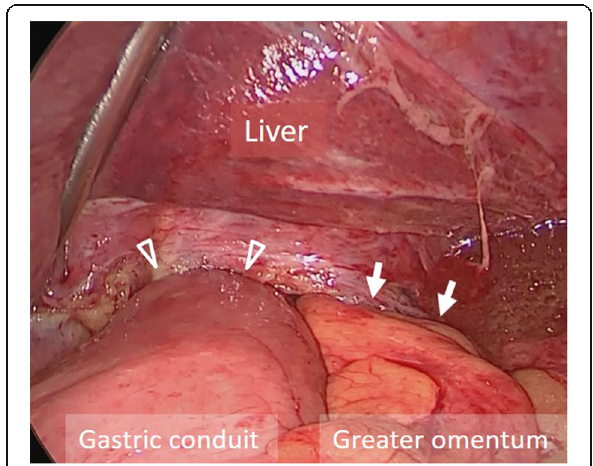
Fig. 4 Another case of narrow gastric tube reconstruction in laparoscopic view. Greater omentum with right gastroepiploic artery (arrows) was located in the left side of gastric conduit (arrowheads)